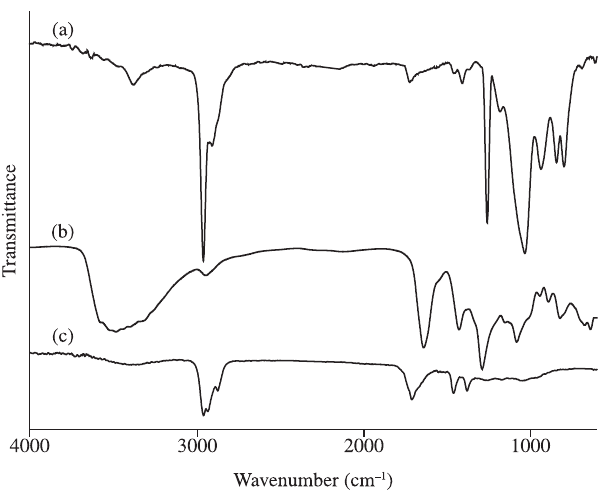
Figure 1. Infrared absorption spectra of a film deposited in heparin / HMDSO plasma (a); sodium heparin powder (b); a film deposited in heparin / isopro- panol plasma (c).